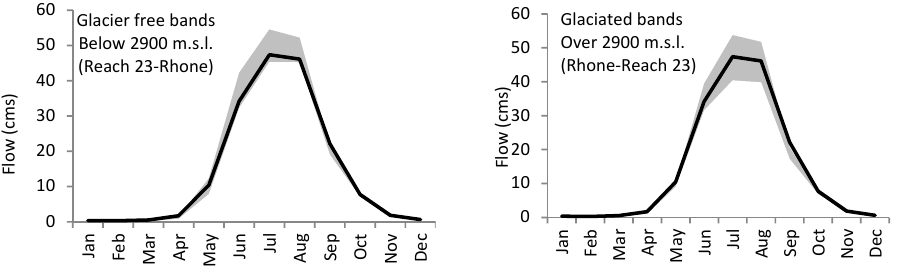
Figure 5. Variability of monthly flow from Reach 23 (65% glaciered area) to SMFMX changes (2 to 8 mm/d − 1 ∙ c − 1 ) in the upper and lower elevation bands. Glacier ‐ free bands Below 2900 m.s.l.